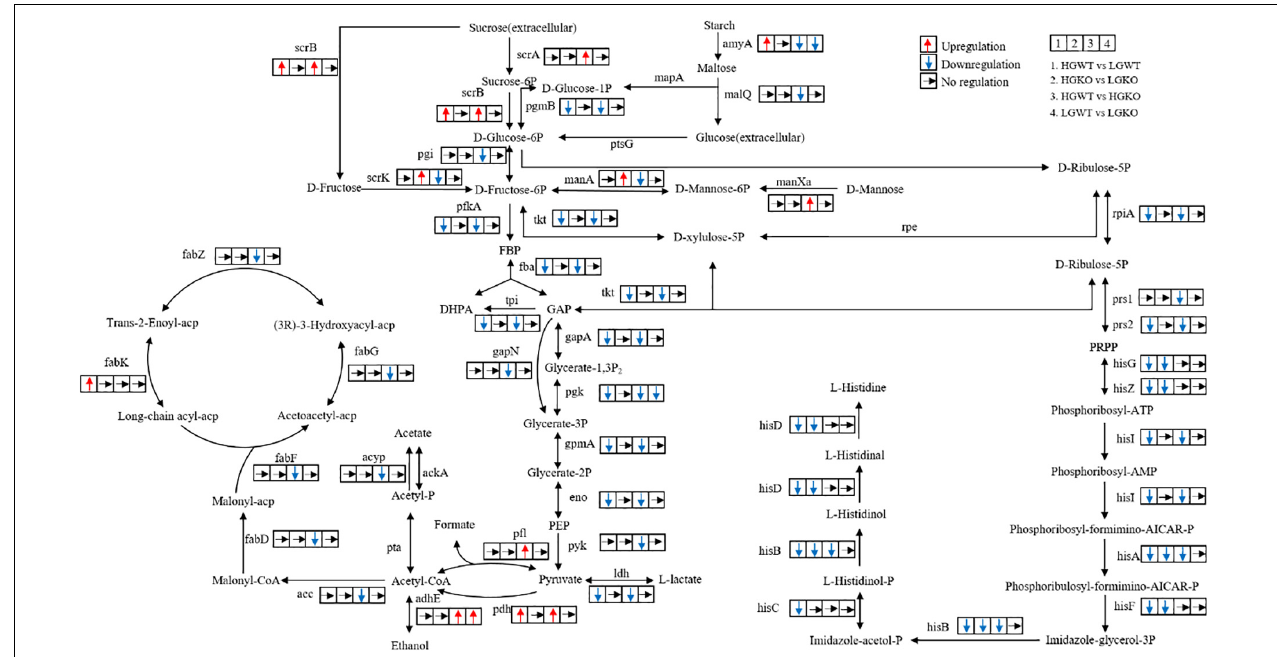
FIGURE 4 | Overview of the key genes and related pathways changed in the transcriptomic analysis. 1, the comparison between wild-type strain grown in glucose-excess and -limited conditions; 2, the comparison between ccpA mutant grown in glucose-excess and -limited conditions. 3, the comparison between wild-type and its ccpA mutant grown in glucose-excess condition; 4, the comparison between wild-type and its ccpA mutant grown in glucose-limited condition. Gene annotation: scrA, sucrose PTS system EIIBCA or EIIBC component; scrB, beta-fructofuranosidase; scrK, fructokinase; amyA, alpha-amylase; malQ, 4-alpha-glucanotransferase; mapA, maltose phosphorylase; pgmB, beta-phosphoglucomutase; ptsG, glucose PTS system EIICB or EIICBA component; pgi, glucose-6-phosphate isomerase; manXa, mannose PTS system EIIA component; manA, mannose-6-phosphate isomerase; pfkA, 6-phosphofructokinase; fba, fructose-bisphosphate aldolase; tpi, triosephosphate isomerase; gapA, glyceraldehyde 3-phosphate dehydrogenase; gapN, glyceraldehyde-3-phosphate dehydrogenase (NADP+); pgk, phosphoglycerate kinase; gpmA, 2,3-bisphosphoglycerate-dependent phosphoglycerate mutase; eno, enolase; pyk, pyruvate kinase; ldh, L-lactate dehydrogenase; pfl, formate C-acetyltransferase; pdh, pyruvate dehydrogenase complex (pyruvate dehydrogenase E1 component, dihydrolipoamide dehydrogenase, pyruvate dehydrogenase E2 component); adhE, acetaldehyde dehydrogenase/alcohol dehydrogenase; pta, phosphate acetyltransferase; acyP, acylphosphatase; ackA, acetate kinase; acc, acetyl-CoA carboxylase; fabD, [acyl-carrier-protein] S-malonyltransferase; fabF, 3-oxoacyl-[acyl-carrier-protein] synthase II; fabG, 3-oxoacyl-[acyl-carrier protein] reductase; fabZ, 3-hydroxyacyl-[acyl-carrier protein] dehydratase; fabK, enoyl-[acyl-carrier protein] reductase II; tkt, transketolase; rpe, ribulose-phosphate 3-epimerase; rpiA, ribose 5-phosphate isomerase A; prs, ribose-phosphate pyrophosphokinase; hisG, ATP phosphoribosyltransferase; hisZ, ATP phosphoribosyltransferase regulatory subunit; hisI, phosphoribosyl-AMP cyclohydrolase;